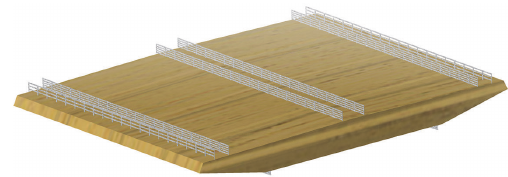
Figure 5: Details of computational model in CFD simulations.